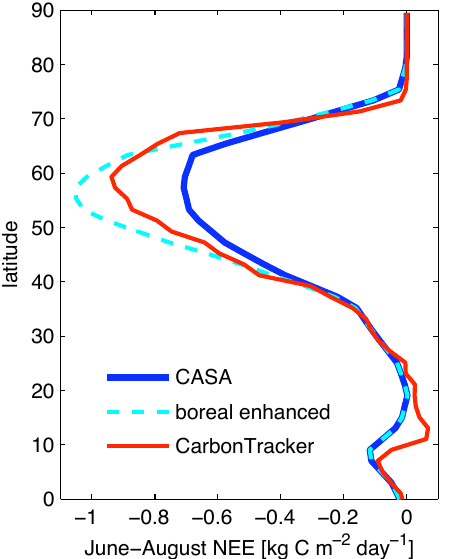
Fig. 13. Zonal mean net ecosystem exchange averaged for June– August from CASA (solid blue), boreal enhanced CASA (dashed cyan) and optimized CarbonTracker for 2008 (solid red). Carbon- Tracker increases boreal fluxes during its assimilation of boundary layer [CO 2